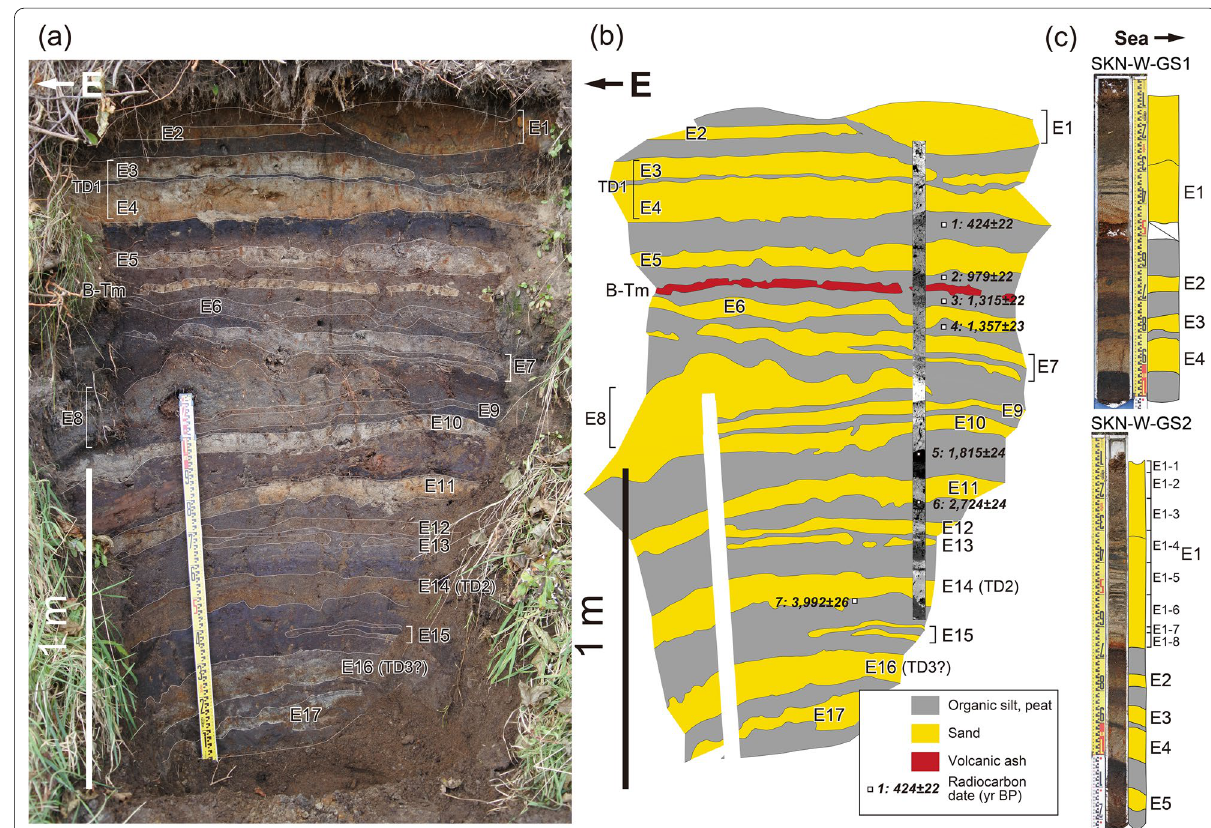
Fig. 4 SKN-W outcrop. a Photograph of SKN-W outcrop. b Sketch of SKN-W outcrop. c Photographs and sketches of GS cores drilled behind the SKN-W outcrop. Grayscale columns on the sketch are XCT images. a , b Show the same